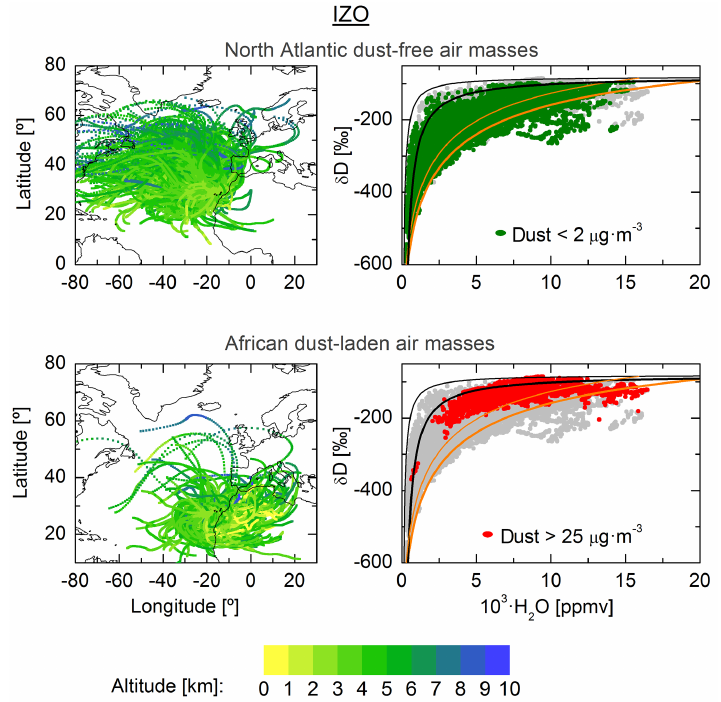
Figure 5. Air masses reaching IZO station as a function of the dust load. First row shows non-dust conditions, second row, dust-laden conditions. The colour-bar indicates the altitude (km) of these air masses in each grid. The left column shows the trajectories. The right column shows the H 2 O- δ D distribution (pairs are presented on 10min average): all data (grey dots), data measured under non-dust conditions (green dots) and data for dust-laden conditions (red dots). Orange lines represent the evolution of an air mass that has experienced Rayleigh distillation for RH = 80% and SST = 18 ◦ C (thin line) and SST = 25 ◦ C (thick line) respectively. These temperatures cover the annual mean sea surface temperatures around the Canaries. The thin black line represents the mixing between a moist air mass (initial conditions: H 2 O = 18000ppmv, δ D = − 84‰) and a dry air mass (initial conditions: H 2 O = 400ppmv, δ D = − 600‰). The thick black line represents another mixing process (initial conditions for moist end member: H 2 O = 16000ppmv, δ D = − 93‰; initial conditions for dry end member: H 2 O = 400ppmv, δ D = −